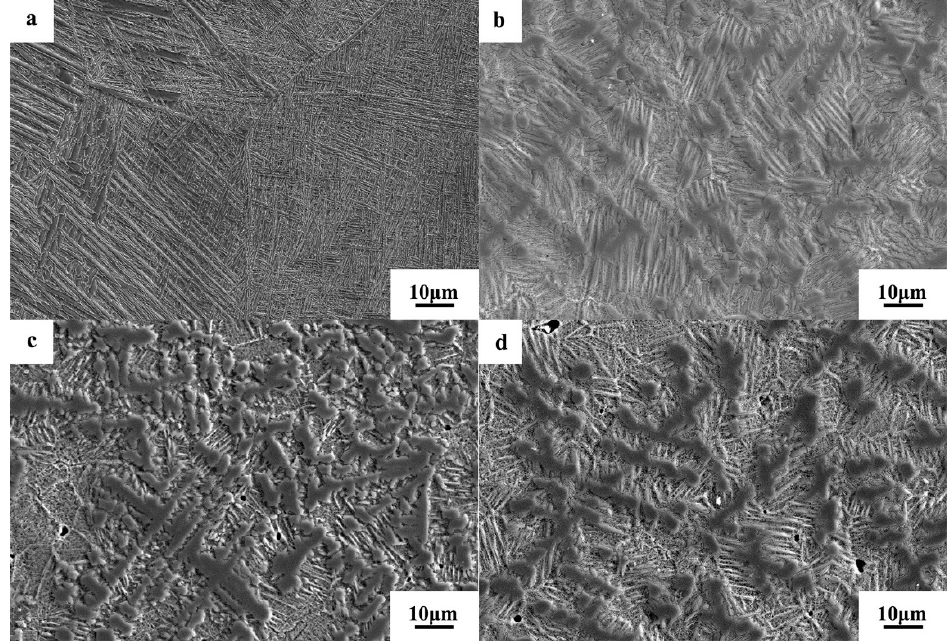
Figure 2. Microstructures of the coating with different ZrN additions ( a ) 10 wt.% (10ZrN), ( b ) 20 wt.% (20ZrN), ( c ) 30 wt.% (30ZrN), and ( d ) 40 wt.% (40ZrN).